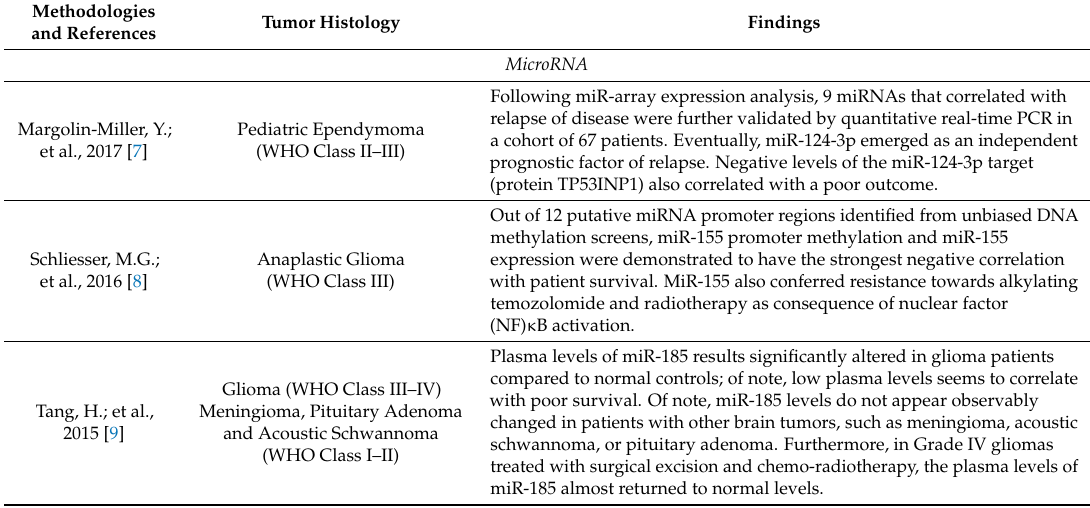
Table 1. Nanotech and Biomedical Engineering advances in identification of MicroRNA biomarkers in neuro-oncology.